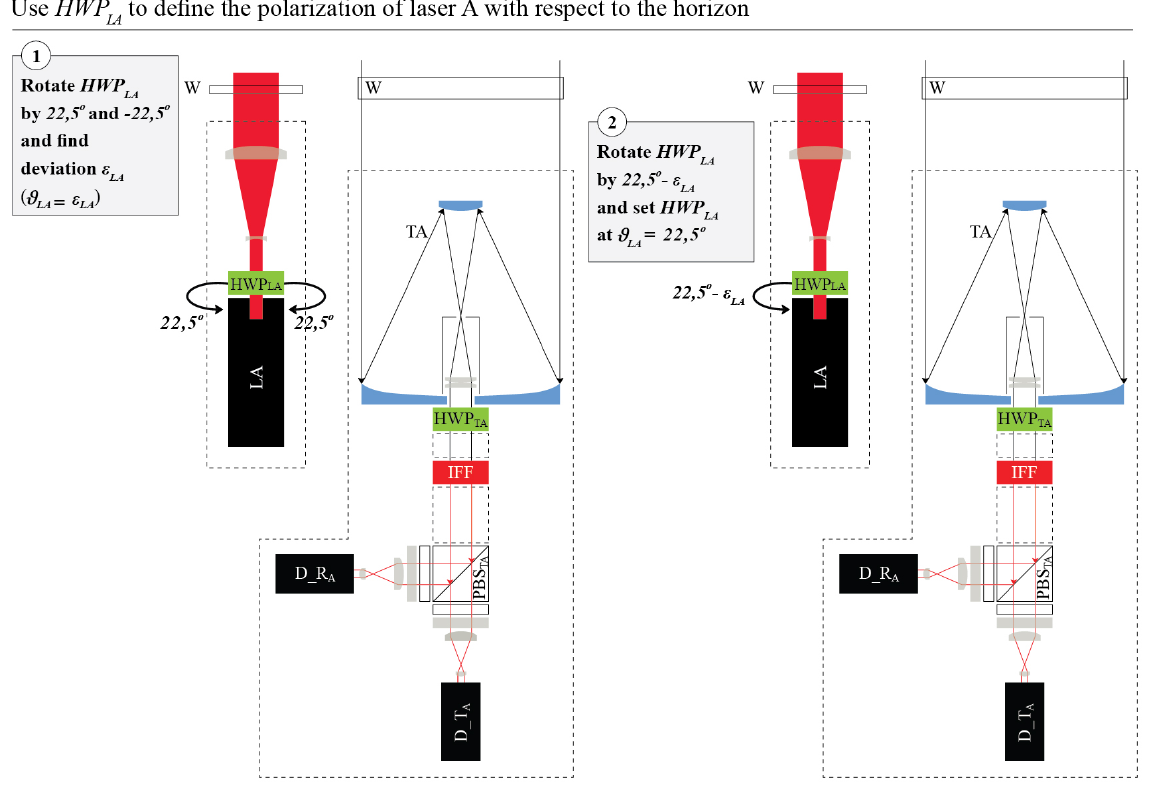
Figure 11. Methodology for defining the polarization of the light from the emission unit of laser A, with respect to the